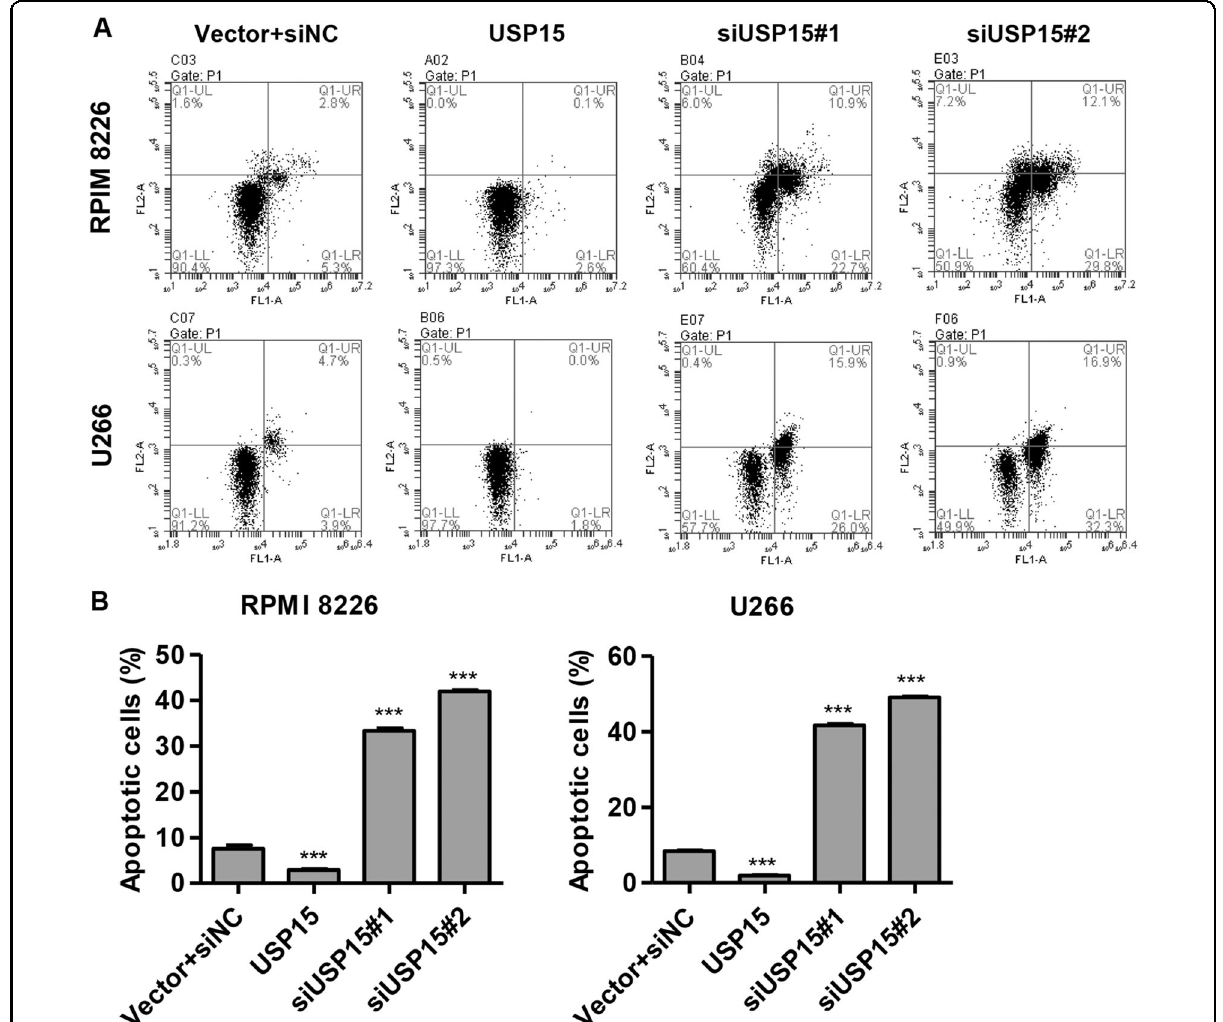
Fig. 3 USP15 overexpression inhibits MM cell apoptosis. a , b After RPMI 8226 and U266 cells were transfected with siNC plus empty pLVX-Puro (vector), siUSP15#1, siUSP15#2, or pLVX-Puro-USP15 for 48 h, apoptosis in the RPMI 8226 and U266 cells was measured by fl ow cytometry with Annexin V-FITC/PI staining. *** P < 0.001 compared with vector +